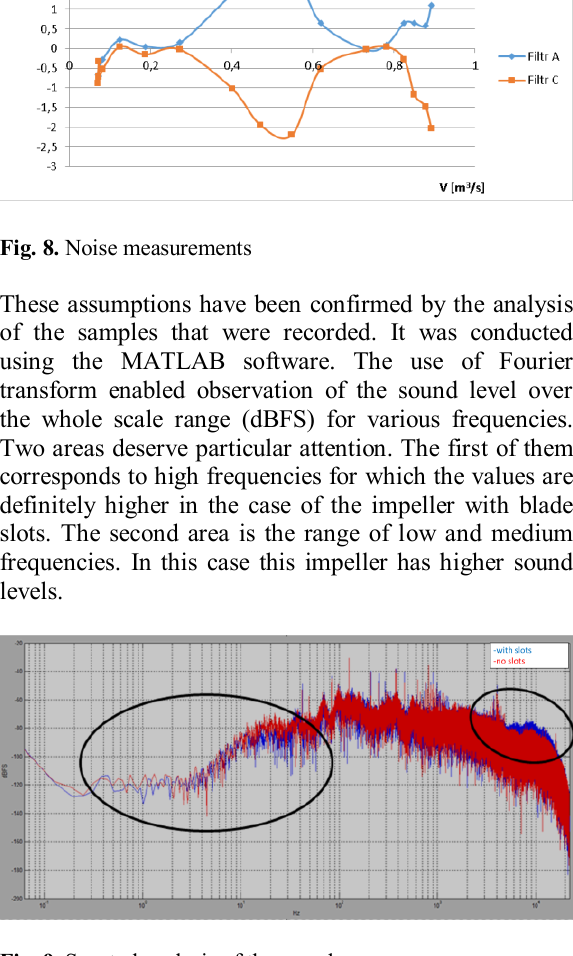
Fig. 9. Spectral analysis of the